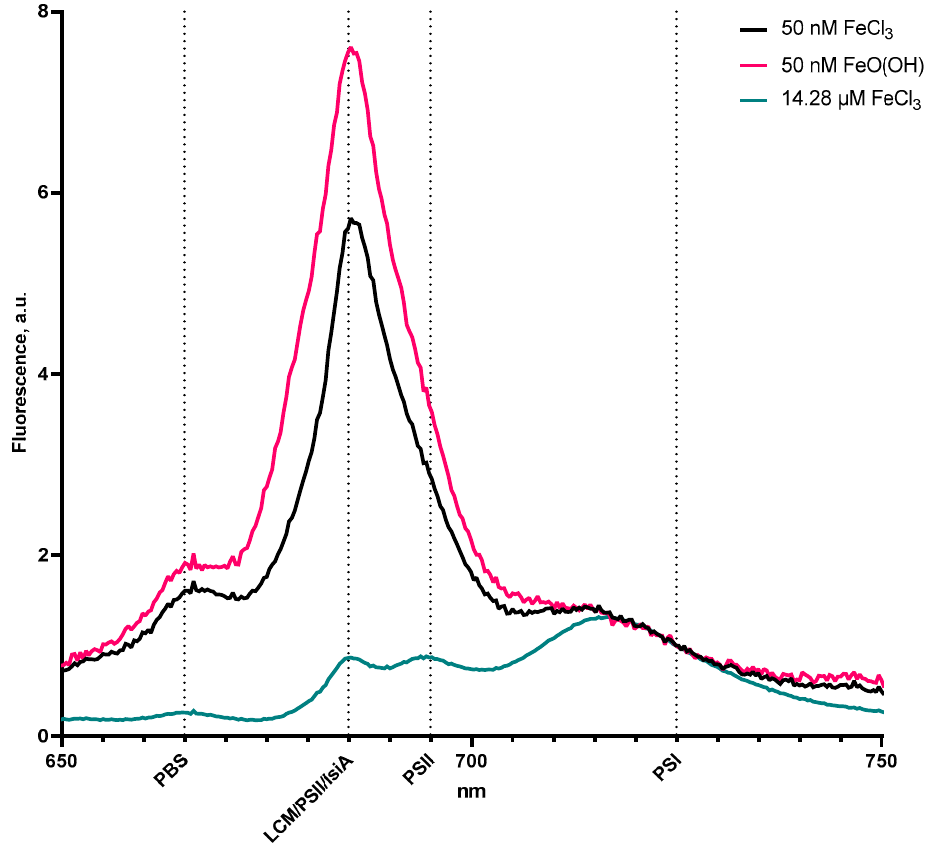
Figure 2. 77 K fluorescence emission spectra of cultures grown on FeCl 3 and FeO(OH) that were acquired with an excitation wavelength of 440 nm. Peaks attributed to phycobilisomes (PBS), a combined contribution from photosystem II (PSII), the protein complex iron-stress inducible protein (IsiA) and the terminal phycobilisome emitter (LCM), PSII, and photosystem I (PSI) are indicated with dotted lines. The green line shows the fluorescence emission signal from the Synechococcus culture grown under iron-replete conditions of 14.28 µ M FeCl 3 [25]. The signal was normalized to the 725 peak for better visual representation.